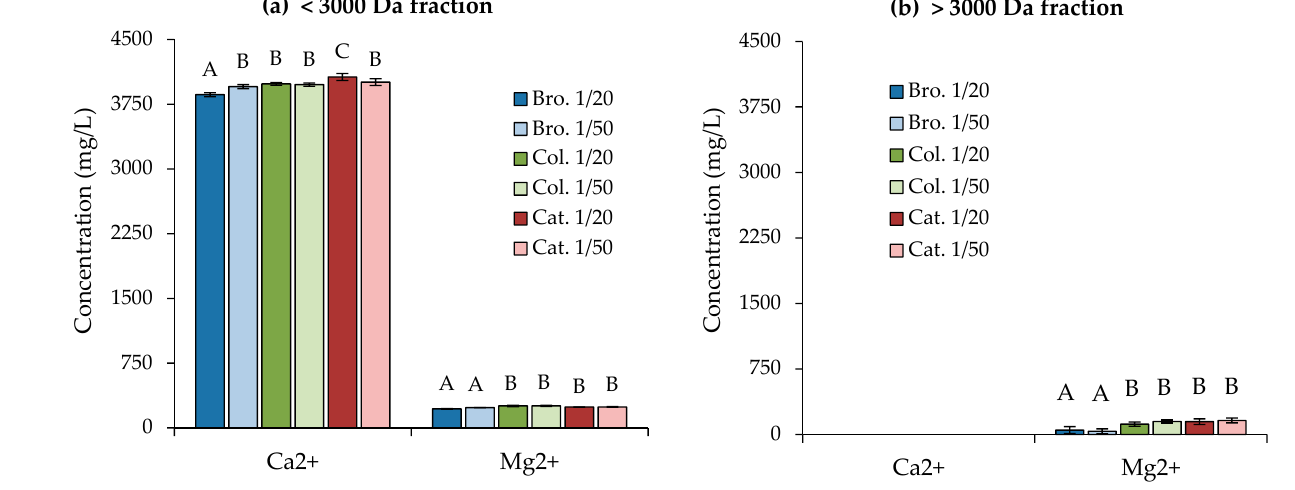
Figure 2. Calcium and magnesium content in the solutions (Bro. = bromelain, Col. = collagenase B, Cat. = cathepsin B) (( a ) < 3000 Da and ( b ) > 3000 Da) according to the enzyme used and the enzyme:collagen ratio (mean ± standard deviation). Different uppercase letters above columns indicate statistical differences among values ( p <